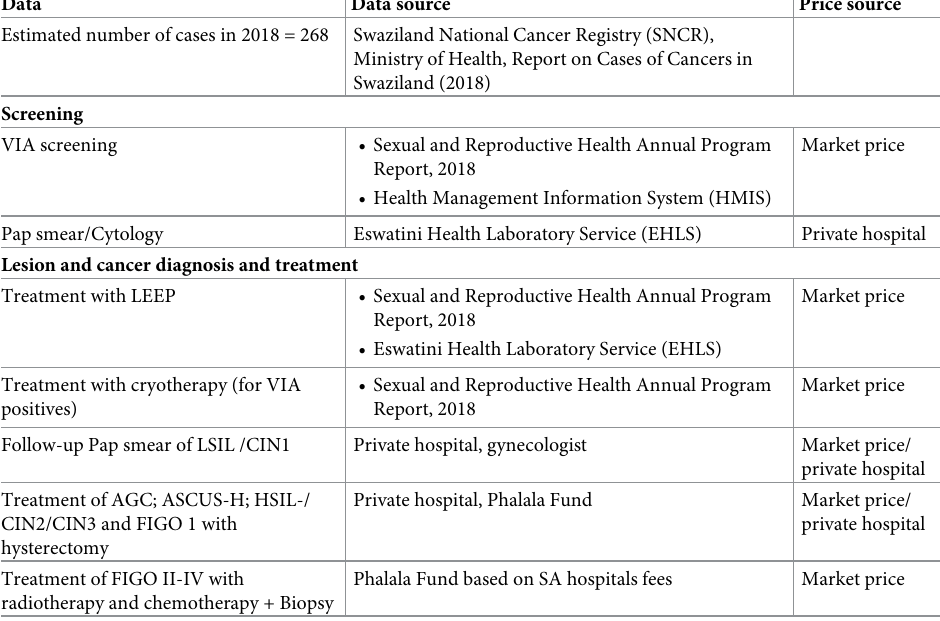
Table 1. Data variables and source for costs regarding screening, management and treatment of cervical lesions and cervical